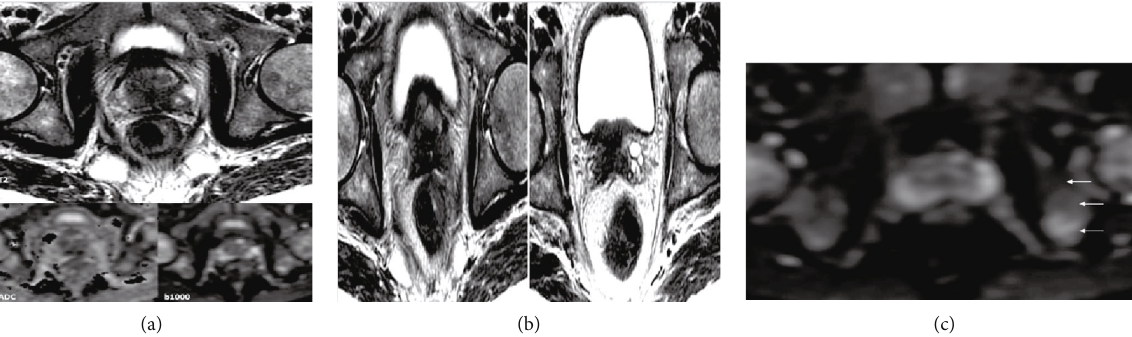
Figure 2: (a) Multiparametric MRI image showing a suspicious nodule with capsular intrusion and invasion of the rectal wall. Nodular image sitting at the level of the left CZ sector of the prostatic base in heterogeneous hyposignal on the T2-weighted images, in hypersignal B1000 di ff usion with restriction on the ADC card. Note a rupture of the prostatic capsule with invasion of the left neurovascular strip and thickening of the rectal wall (isosignal T2 and hypersignal in di ff usion). (b) T2 sequence of a multiparametric MRI of the prostate objectifying an invasion of the base of the seminal vesicles T2 hyposignal aspect of the base of the seminal vesicles denoting their invasion. (c) B1000 di ff usion sequence of a multiparameter MRI objectifying an associated secondary bone involvement, with a heterogeneous aspect of the bone